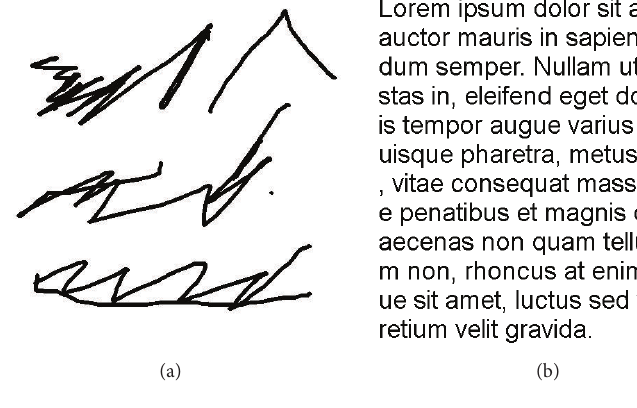
Figure 1: (a) Inpaint damage; (b) text damage; (c) noise damage.